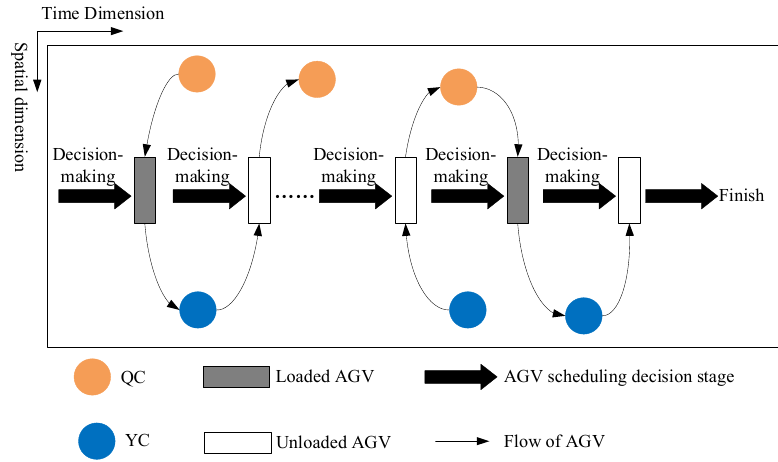
Figure 2. The dynamic scheduling process of a single AGV.